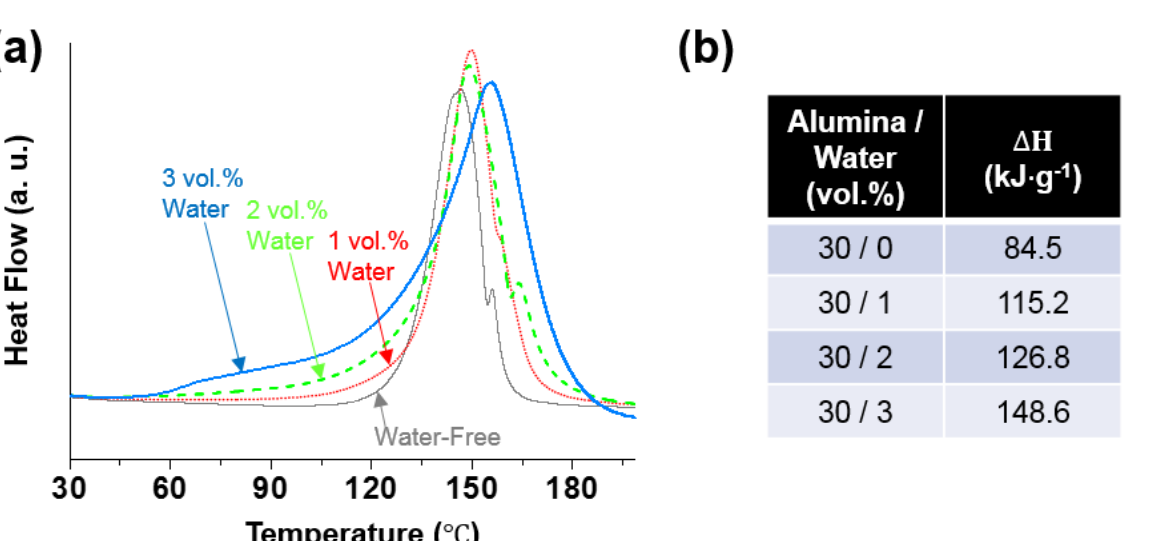
Figure 6. ( a ) DSC curves for uncured water-stained epoxy – alumina inks at fixed alumina concentration of 30 vol.% with various water contents (0 − 3%). ( b ) Total enthalpies ( ∆ H in kJ ∙ g − 1 ) during heating, obtained from DSC measurements.